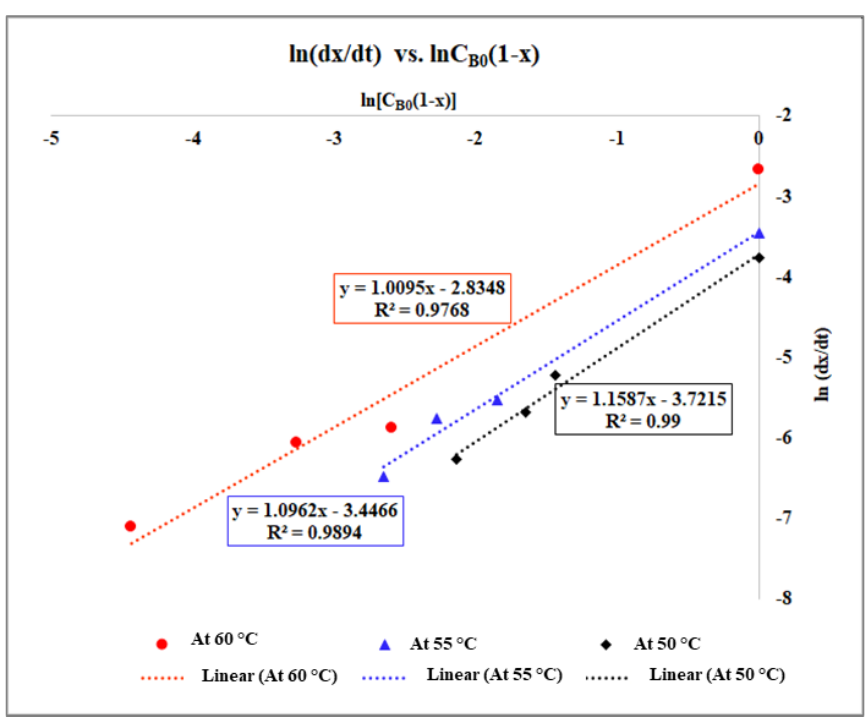
Figure 21. ln( dx / dt ) vs. lnC B0 (1 − x ) graph plot for the reaction kinetics of the WCO transesterifica- Figure 21. ln ( dx / dt ) vs. ln C B 0 (1 − x ) graph plot for the reaction kinetics of the WCO transesterification. tion.